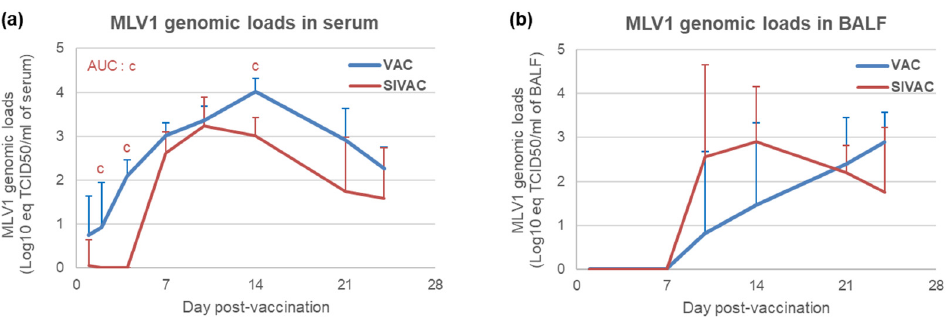
Figure 6. Porcine reproductive and respiratory syndrome virus (PRRSV) genomic loads in ( a ) serum or in ( b ) BALF . All data are reported as the mean (± SD) of the results obtained from all piglets in each group. Letter (c) indicates that the SIVAC group was significantly different from the VAC group with p < 0.05. AUC: area under the curve.